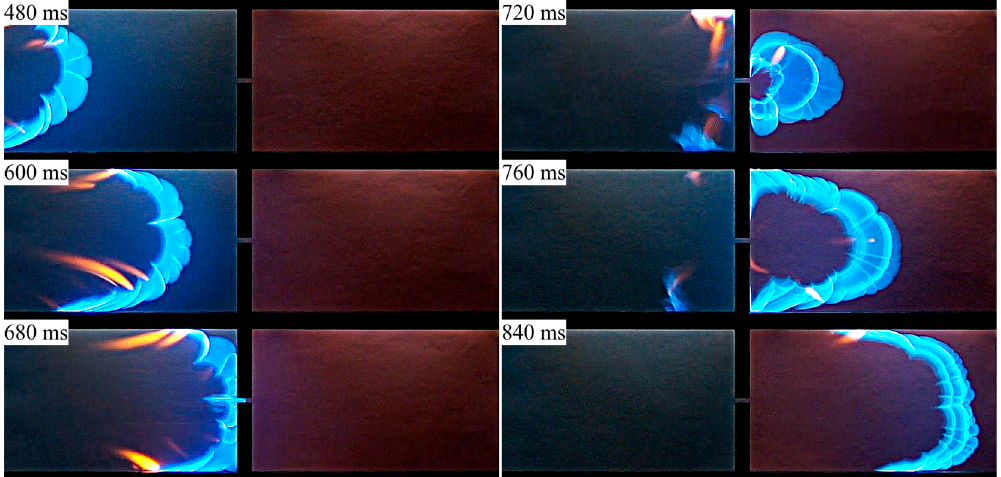
Figure 8. Flame penetration through a hole from the open ( left ) to closed ( right ) channel part: experiments in a channel with distance between plates of 9 mm, 5.5% propane–air mixture. Numerical simulations of flame front passage through the hole are presented in Figures 9 and 10 (note that in the simulations the mesh was the same as in Section 4.1, only the boundary conditions on the left and right channel boundaries were changed from closed to open and vice versa; therefore, in Figures 8 and 9 the flame propagates from right to left).